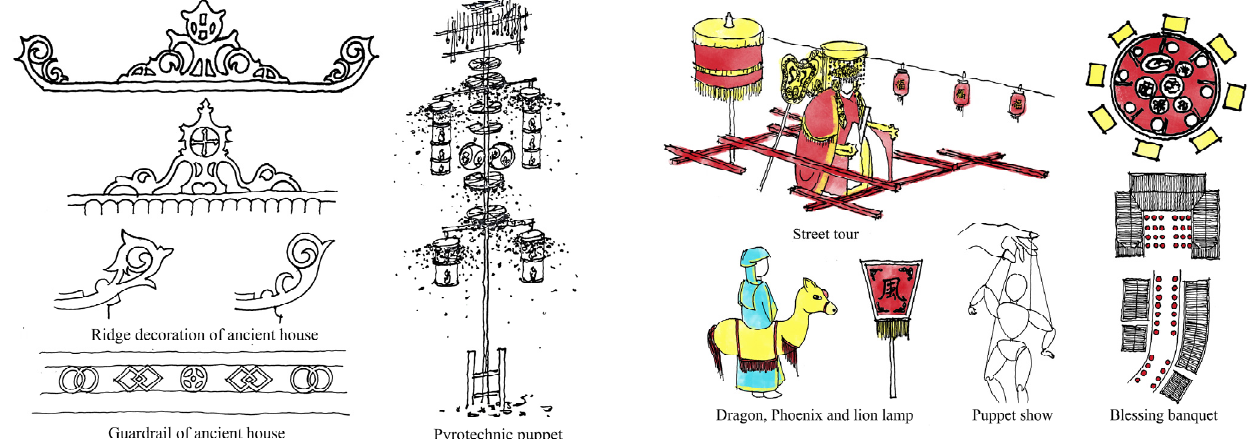
Figure 4. Extraction examples of elements of Hundred-family Feast culture in Taishun.